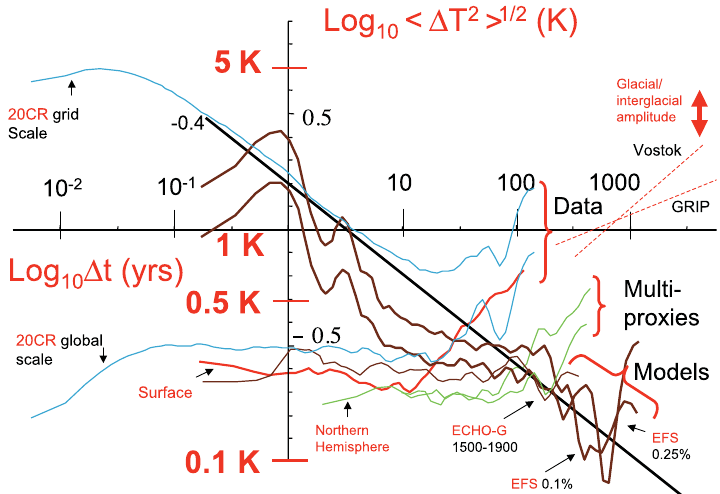
Fig. 7. Pre-1900 forced runs versus data, global scale: this is the same as Fig. 4 (global averages) except that the pre-1900 forced ECHO-G (thin brown) and EFS models (thick brown) are analysed. The upper right dashed lines indicate the rough ranges of the Vostok and GRIP (Greenland ice core) fluctuations at multicentennial scales, and the arrow the glacial–interglacial variations at 50–100kyr. Also shown are the global- and grid-scale S(1t) from the 20th century reanalysis (blue) as well as two curves for the multiproxies (green) shown in Fig. 3 (the top corresponds to the period 1500–1980, the bottom to the period 1500–1900).